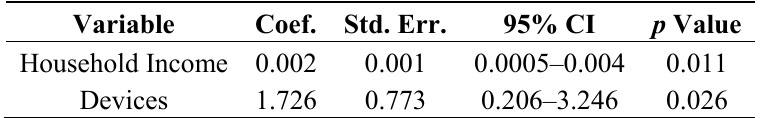
Table 3. Relationship between waist circumference and both household income and the availability of the evaluated electronic devices and transport (vehicle and/or motorcycle) at home.